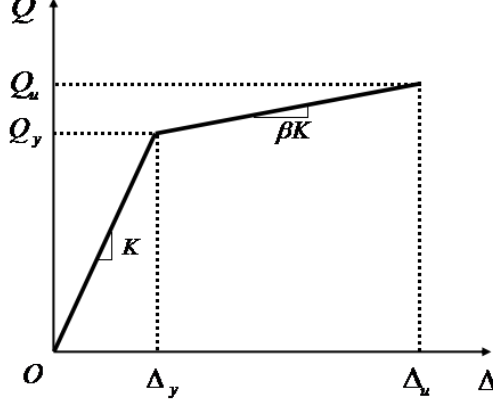
Figure 2. Curve of constitutive relation.